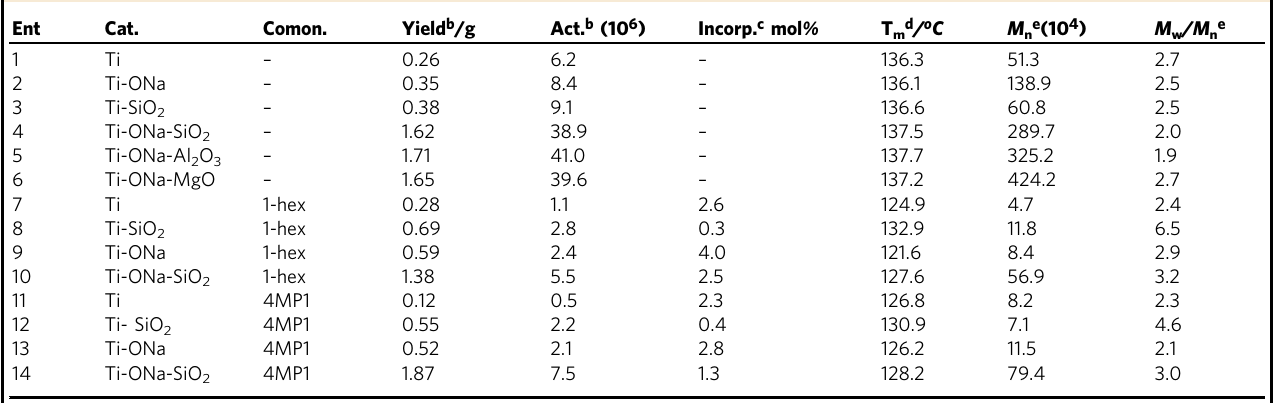
a Conditions: The same metal loading (20 µ mol/g) was used for all solid supports (10 µ mol/g loading for Ti-SiO 2 ); Et 2 AlCl: 500 eq., 3mL (comonomer + n -heptane), T = 30°C, Entry 1 – 6: Ti quantity = 0.25 µ mol, ethylene pressure = 8atm, time = 10min; Entry 7 – 14: Ti quantity = 0.5 µ mol, ethylene pressure = 2atm, time = 30min, comonomer: 2mol·L − 1 . b Polymer yield and activity values are average of at least two runs. Activity = 10 6 gmol − 1 h − 1 . c Comonomer incorporation ratio was determined by NMR in C 2 D 2 Cl 4 at 120°C.